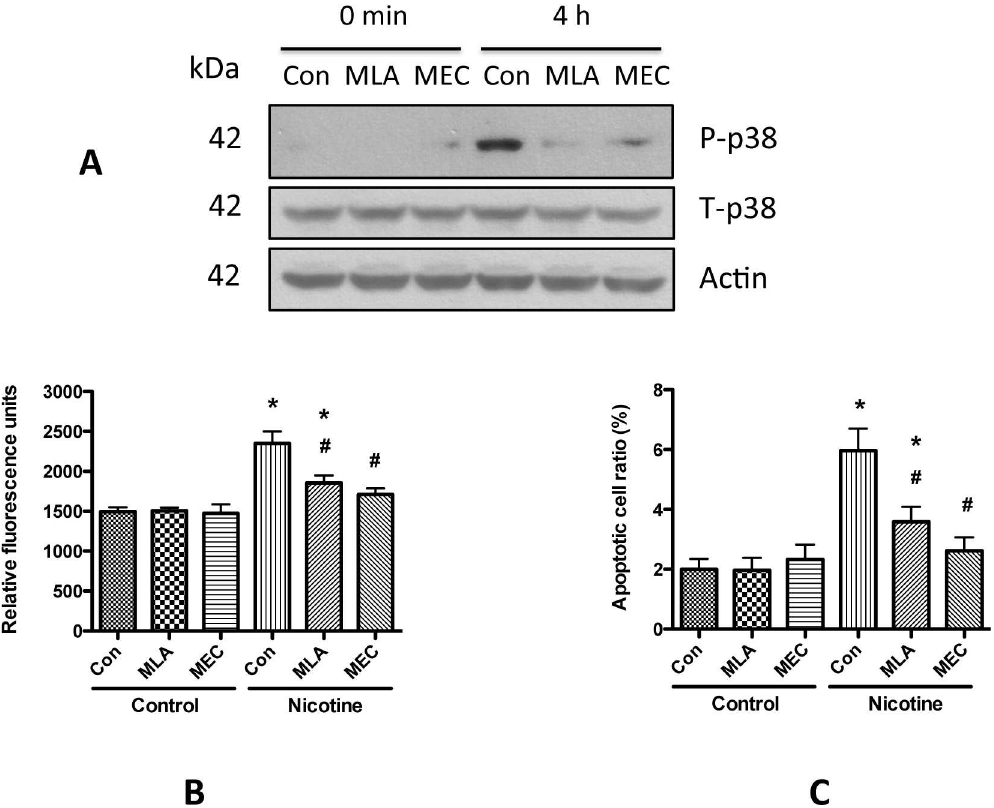
Fig 8. Nicotinic receptor antagonists play important roles in nicotine-induced podocyte injury. A. Differentiated human podocytes were starved in serum free medium for 12 h, pre-treatedwith MLA (20 μ M) or MEC (100 μ M) for 1 h, followedby treatment with 10 μ M nicotinefor another 4 h. Subsequently, the cell lysate was collectedfor Western blottingto detect the phosphorylation of p38. Total p38 and actin were used as internal control. B. Differentiated humanpodocytes were pre-treatedwith MLA (20 μ M) or MEC (100 μ M) for 1 h, and then were treated with 10 μ M nicotine for another 12 h. The cells were labeledwith DCFH and the ROS generation was determinedat 1 hour as describedabove. * p < 0.05 comparedwith blank control, while# p < 0.05 comparedwith morphinetreatment alone. C. Differentiated humanpodocytes were pre-treatedwith MLA (20 μ M) or MEC (100 μ M) for 1 h, followedby treatment with 10 μ M nicotine.After incubation at 37˚C for another 48 h, Hoechst stainingwas carried for morphologicassay for apoptotic cells. Results (mean ± SD) were calculatedfrom 20 images for each treatment. * p < 0.05 compared with blank control, while# p < 0.05 comparedwith morphinetreatment